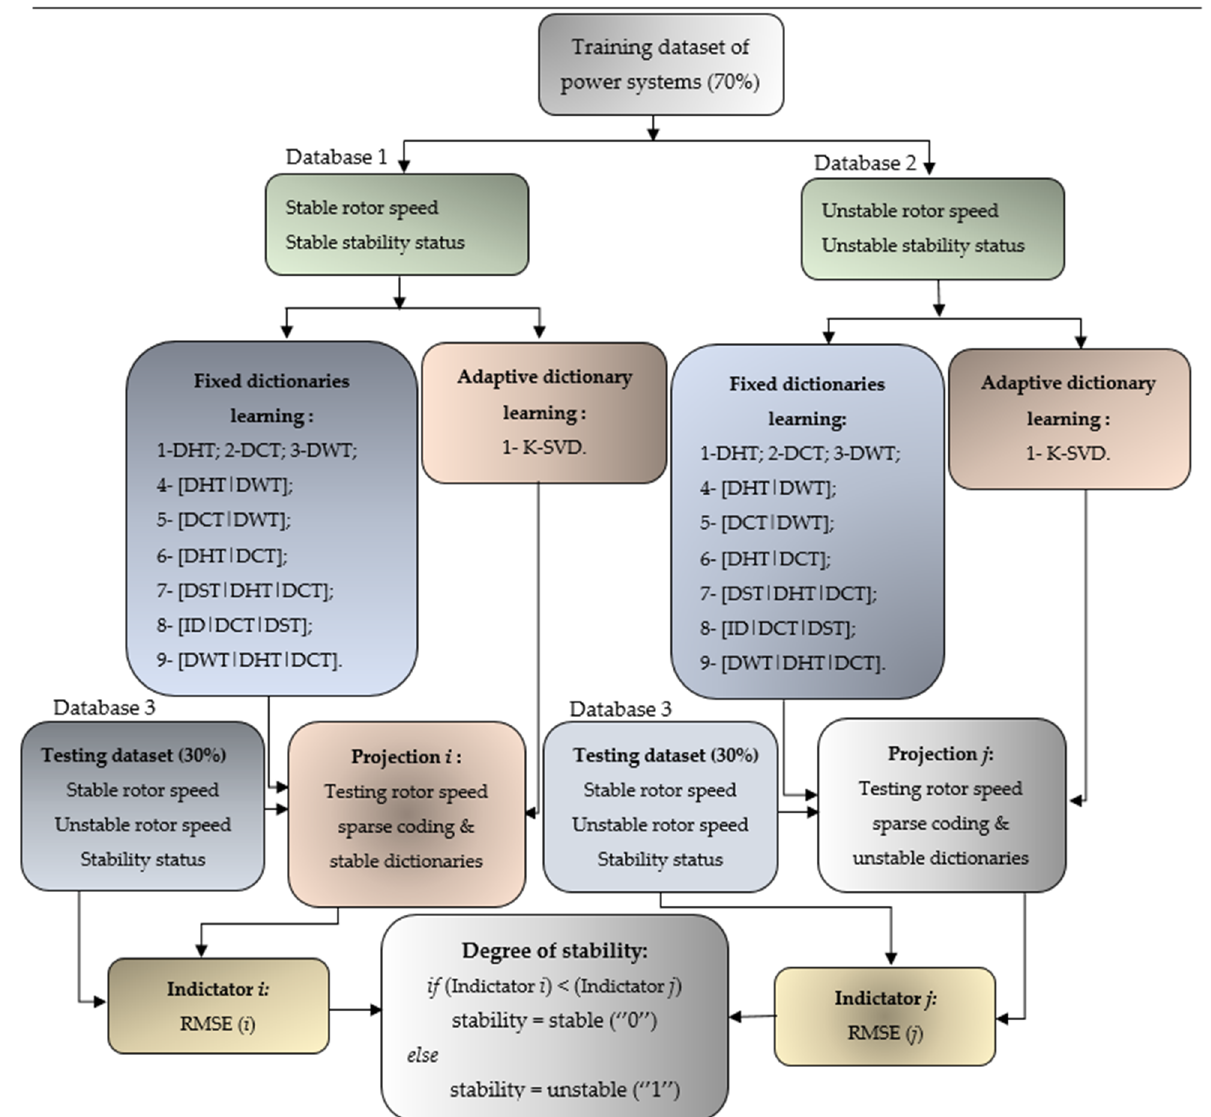
Figure 2. Top-down approaches of supervised dictionary learning for TSA.